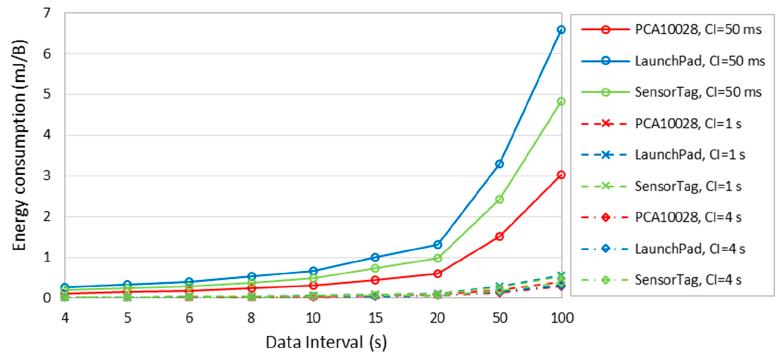
ff erent data intervals, connInterval settings,